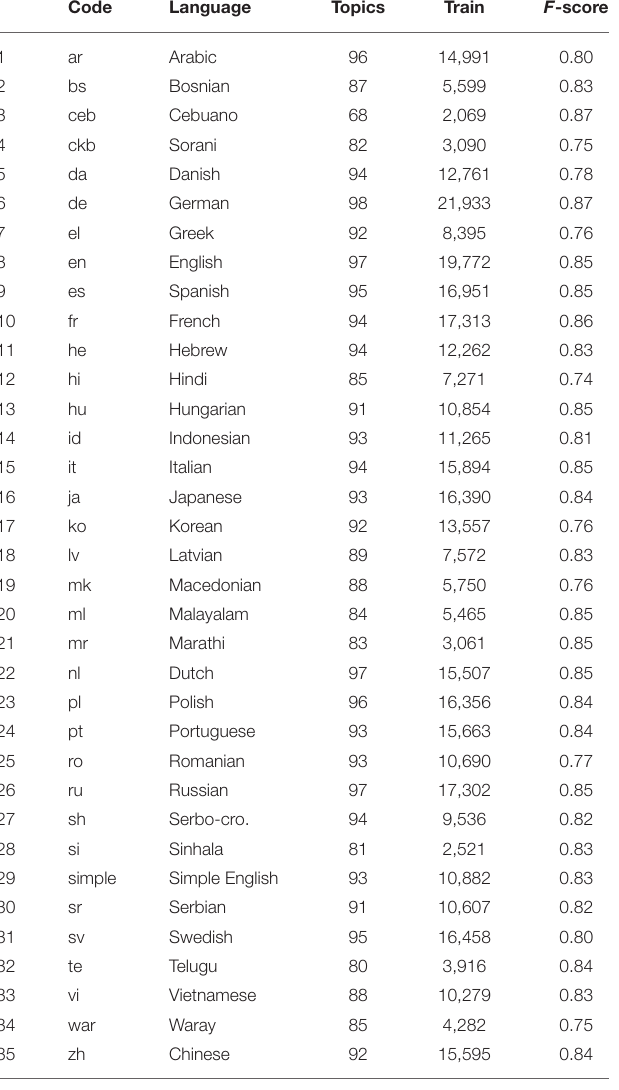
TABLE 2 | Wikipedia language editions, which were analyzed thematically: “Topics” is the number of DDC-based topic classes trained for the corresponding language, “Train” is the number of training examples and “F-score” the harmonic mean of precision and recall of the corresponding